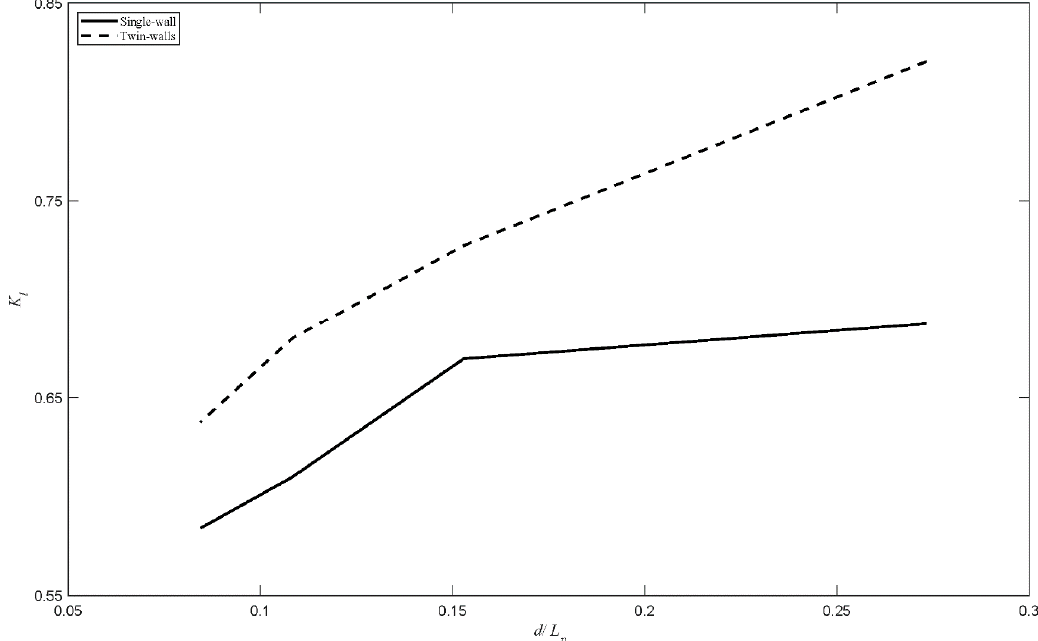
Figure 23. Effect of N on the variation of 𝐾 (cid:3039) with 𝑑 / 𝐿 (cid:3043) . P = 20%, θ = 60°, and 𝐻 (cid:3036)(cid:3046) / 𝑑 = 0.25. Figure 23. E ff ect of N on the variation of K l with d / L p . P = 20%, θ = 60 ◦ , and H is / d =